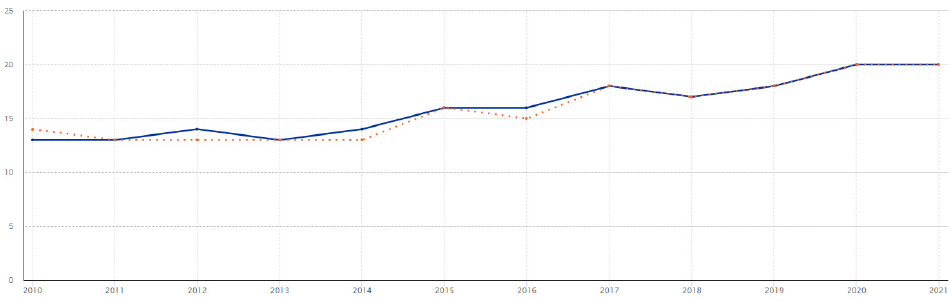
Figure 2. Enterprises that received orders online (as a percentage of the total number of organizations).